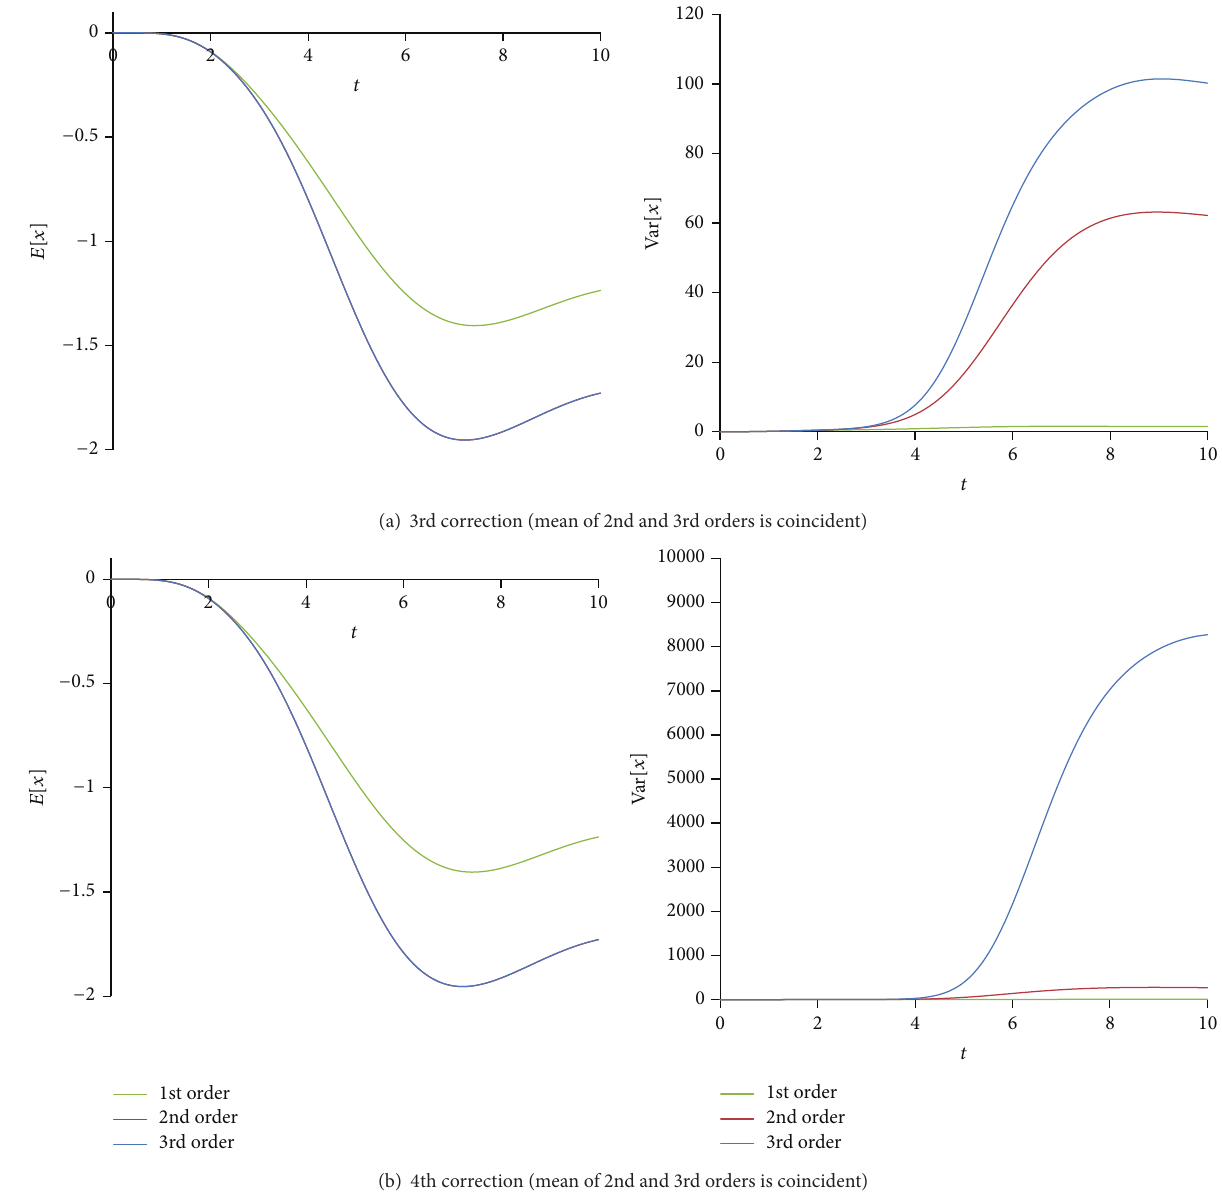
Figure 15: Comparison between the response mean and variance for the first, second, and third orders with numbers of corrections 3 and 4, 𝜀 = 1.0 .